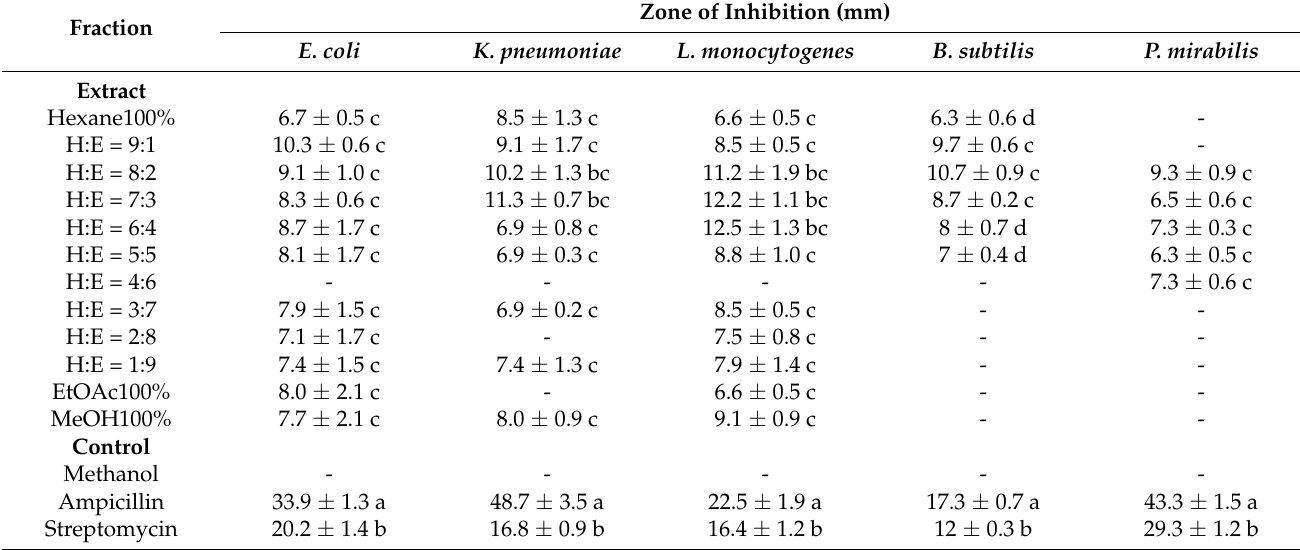
Table 2. Antibacterial activity in term of zone of inhibition (mm) of fractions from M. oleifera twigs.